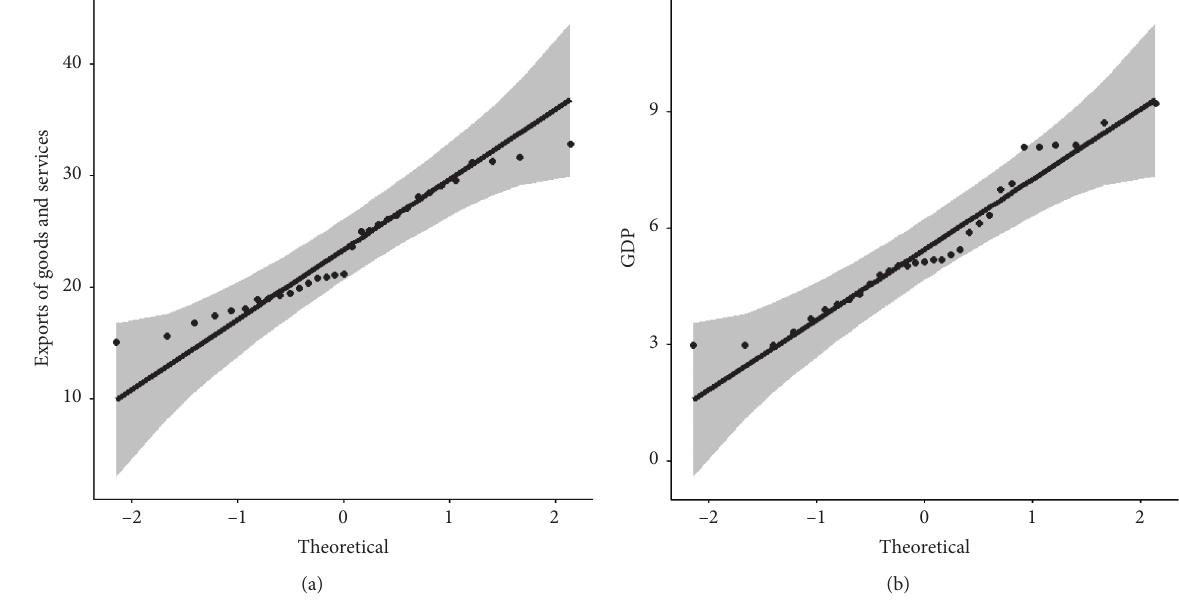
Figure 14: Graphical display of the QQ plot and AD test statistic result. TTT plot of the exports of goods and services